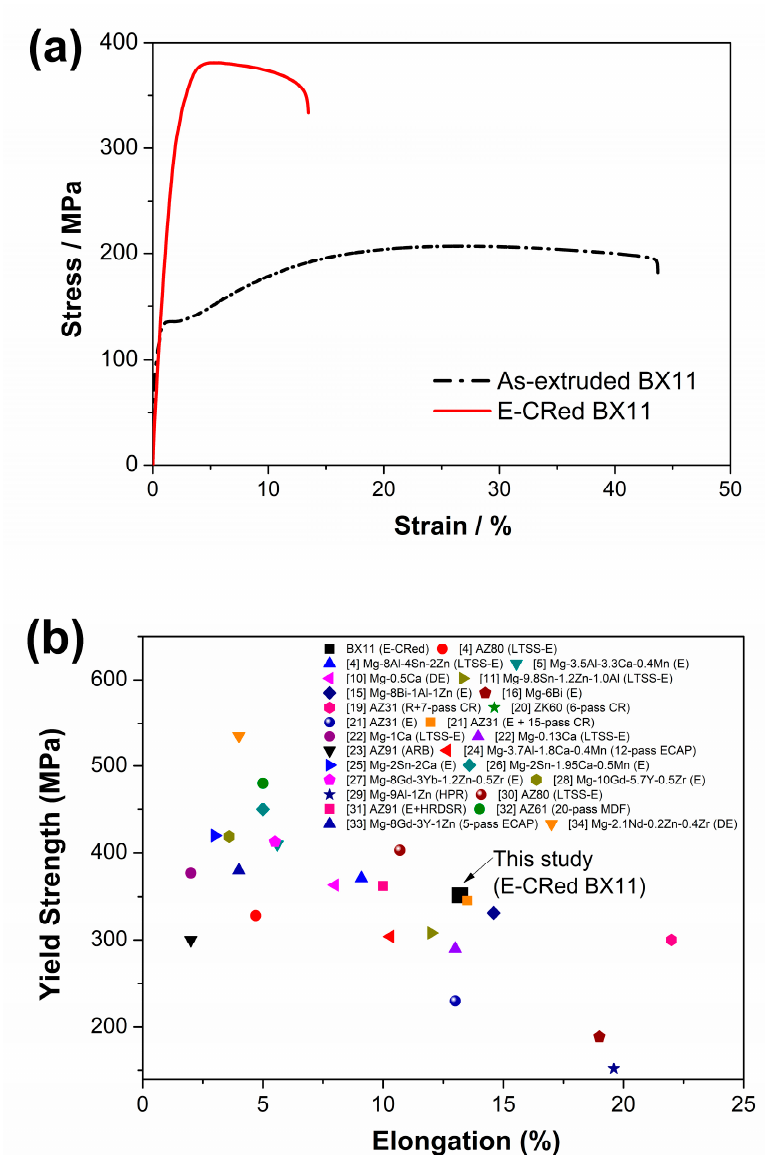
Figure 2. ( a ) Typical engineering tensile stress-strain curve of E-CRed BX11 alloy compared with the as-extruded sample, and ( b ) comparison of yield strength (YS) vs. elongation (EL) of various wrought Mg alloys [4,5,10,11,15,16,19,21–34]. (E: extrusion, CR: caliber rolling, LTSS-E: low temperature slow speed extrusion, DE: double extrusion, ARB: accumulative roll bonding, ECAP: equal channel angular pressing, HPR: hard plate rolling, HRDSR: high-ratio differential speed rolling, and MDF: multi-directional forging.)